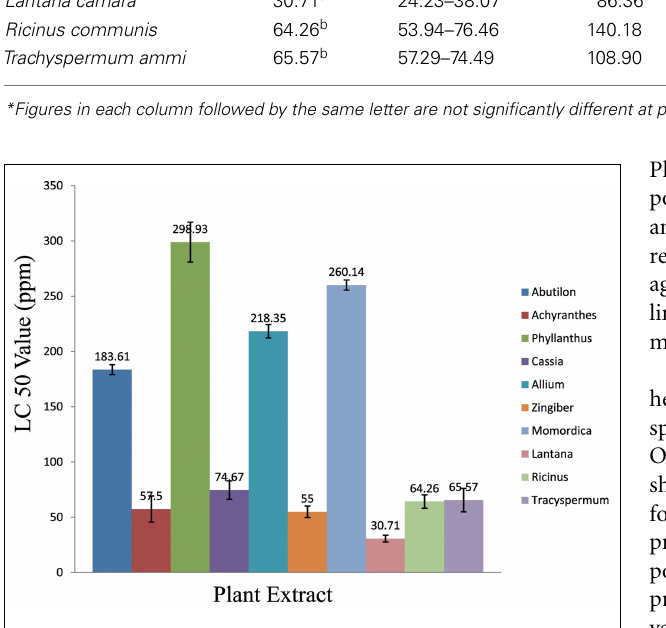
FIGURE 1 | Comparative larvicidal activity of different parts of 10 selected plants against A. aegypti